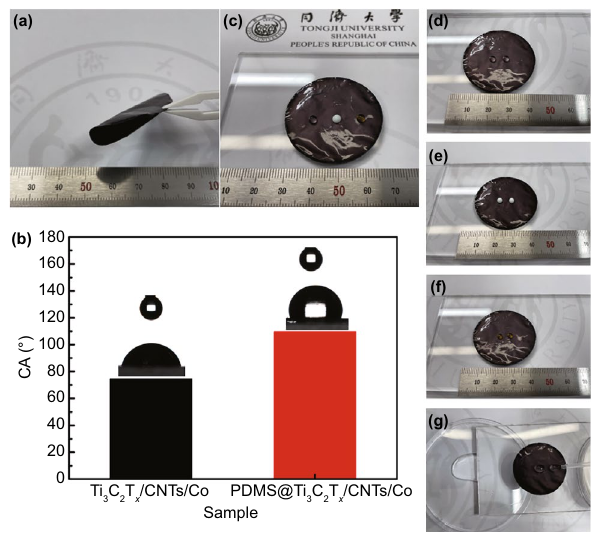
Fig. 5 a Bending photograph of the PDMS@Ti 3 C 2 T x /CNTs/Co film. b Water contact angle (CA) of Ti 3 C 2 T x /CNTs/Co film and PDMS@ Ti 3 C 2 T x /CNTs/Co film. Inset is a photograph of the measurement of water adhesion (3 μL water droplet) on the film surface. c–f Photo- graph of the liquid droplets of water (translucent), milk (white), and coffee (yellow) solution sitting on the surface, g optical photographs of self-cleaning test on coated filter paper. (Color figure